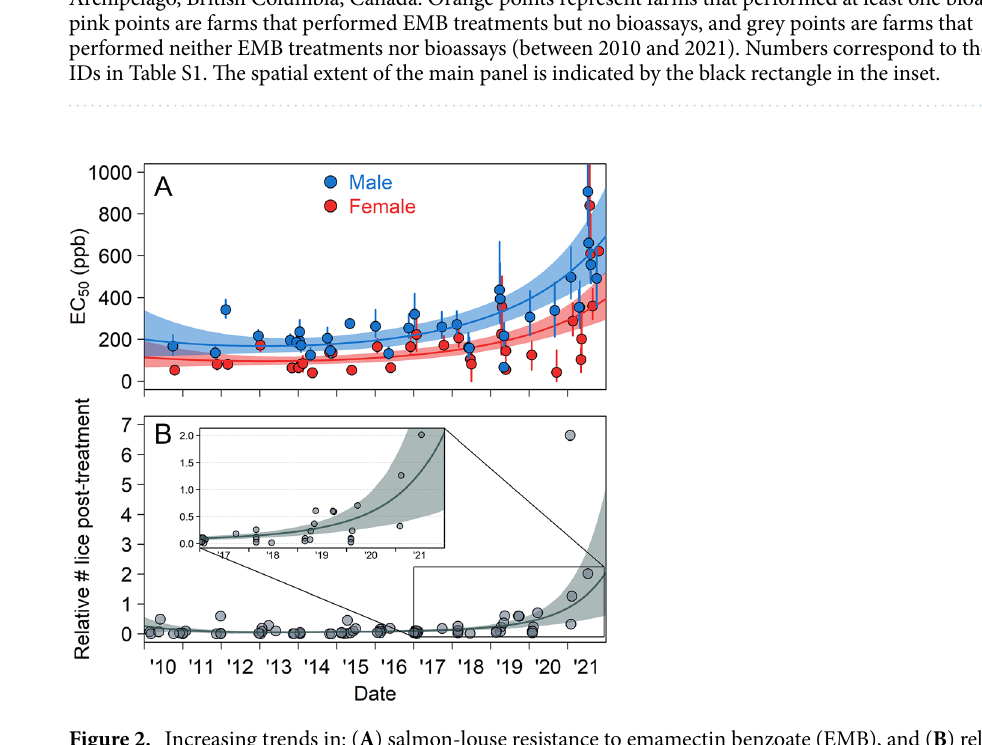
Figure 2. Increasing trends in: ( A ) salmon-louse resistance to emamectin benzoate (EMB), and ( B ) relative salmon-louse counts after EMB treatment. Points in panel ( A ) represent the effective concentrations required to kill 50% of male (blue) or female (red) salmon lice (EC 50 ) in bioassays. Points in panel ( B ) show the relative post-treatment counts (i.e., the post-treatment counts divided by the pre-treatment counts). Lines depict the mean predictions from the top-ranked models. Error bars and shaded regions give 95% confidence